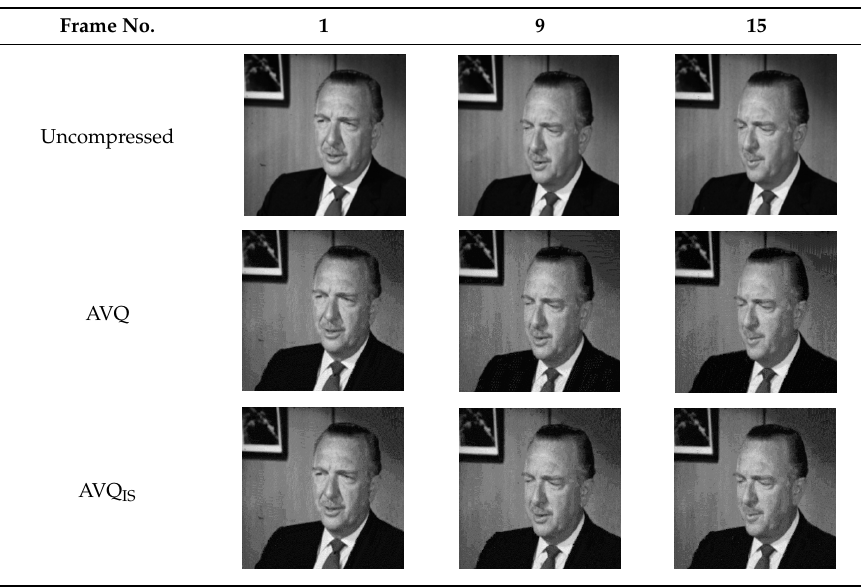
Table A2. Example of some frames from Seq. 2-Dataset 1. Frame No.